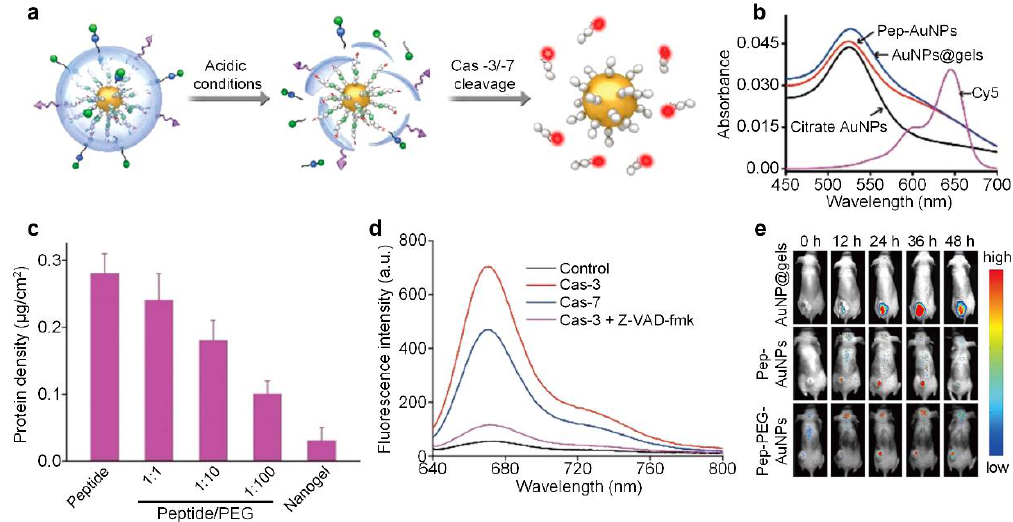
Figure 8. ( a ) Schematic illustration of caspase activity detection by AuNP@gel probes. ( b ) Absorption spectra of citrate-coated AuNPs, pep-AuNPs, AuNPs@gels and Cy5 solutions. ( c ) Quantitative analysis of total absorbed proteins on the surface of AuNPs by bicinchoninic assay (BCA). ( d ) Fluorescence spectra of AuNPs@gels in the presence of Caspase-3 and -7 under different pH. ( e ) Fluorescence images of tumor bearing mice under di ff erent treatments. Adapted from [70]. Copyright © 2019